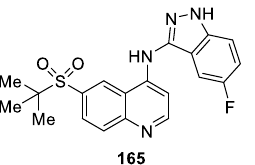
Figure 49. Chemical structure of 6-( tert -Butylsulfonyl)- N -(5-fluoro-1 H -indazol-3-yl)quinolin-4-amine 165.